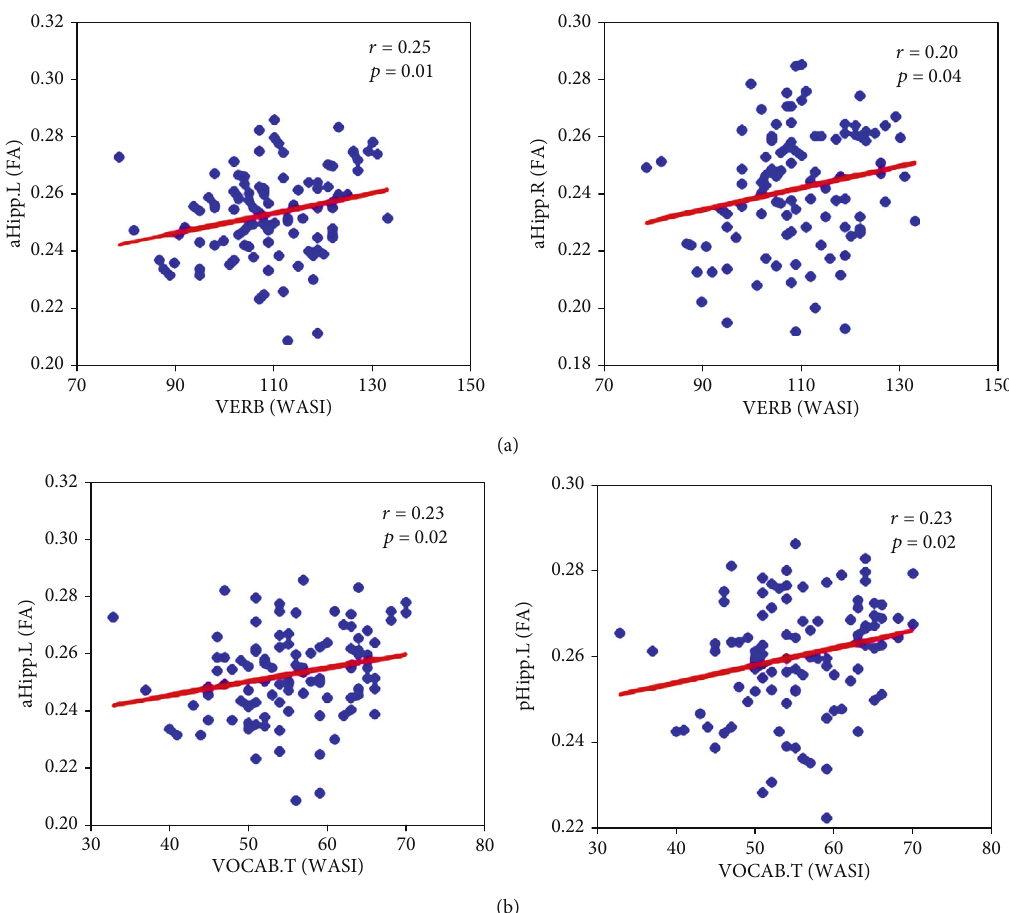
Figure 5: Correlation between hippocampal structural FA values and WASI scores. (a) Correlation between FA values and VERB scores. (b) Correlation between FA values and VOCAB.T